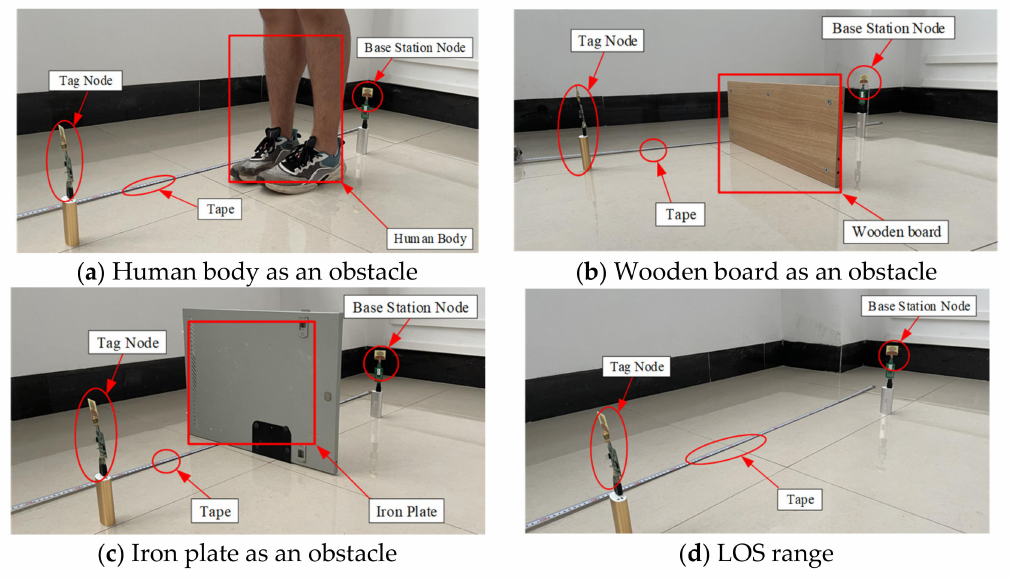
Figure 2. Specific testing environment.